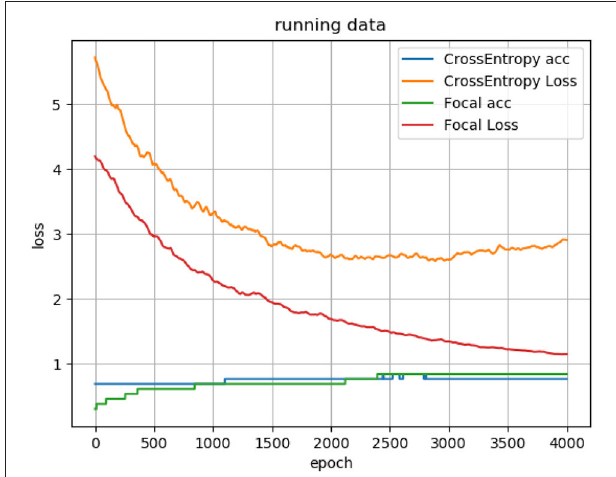
FIGURE 5 | Loss curve and accuracy curve of using focal loss function and cross-entropy loss function for the 1D